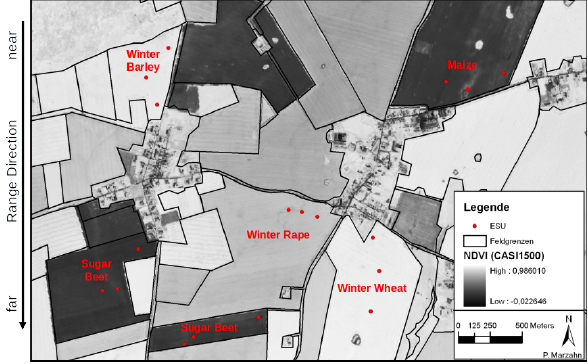
Figure 2. location of sample points (red). (101: Winterrape; 222: Maize; 250: Winterwheat; 440: Winterbarley; 102+460: